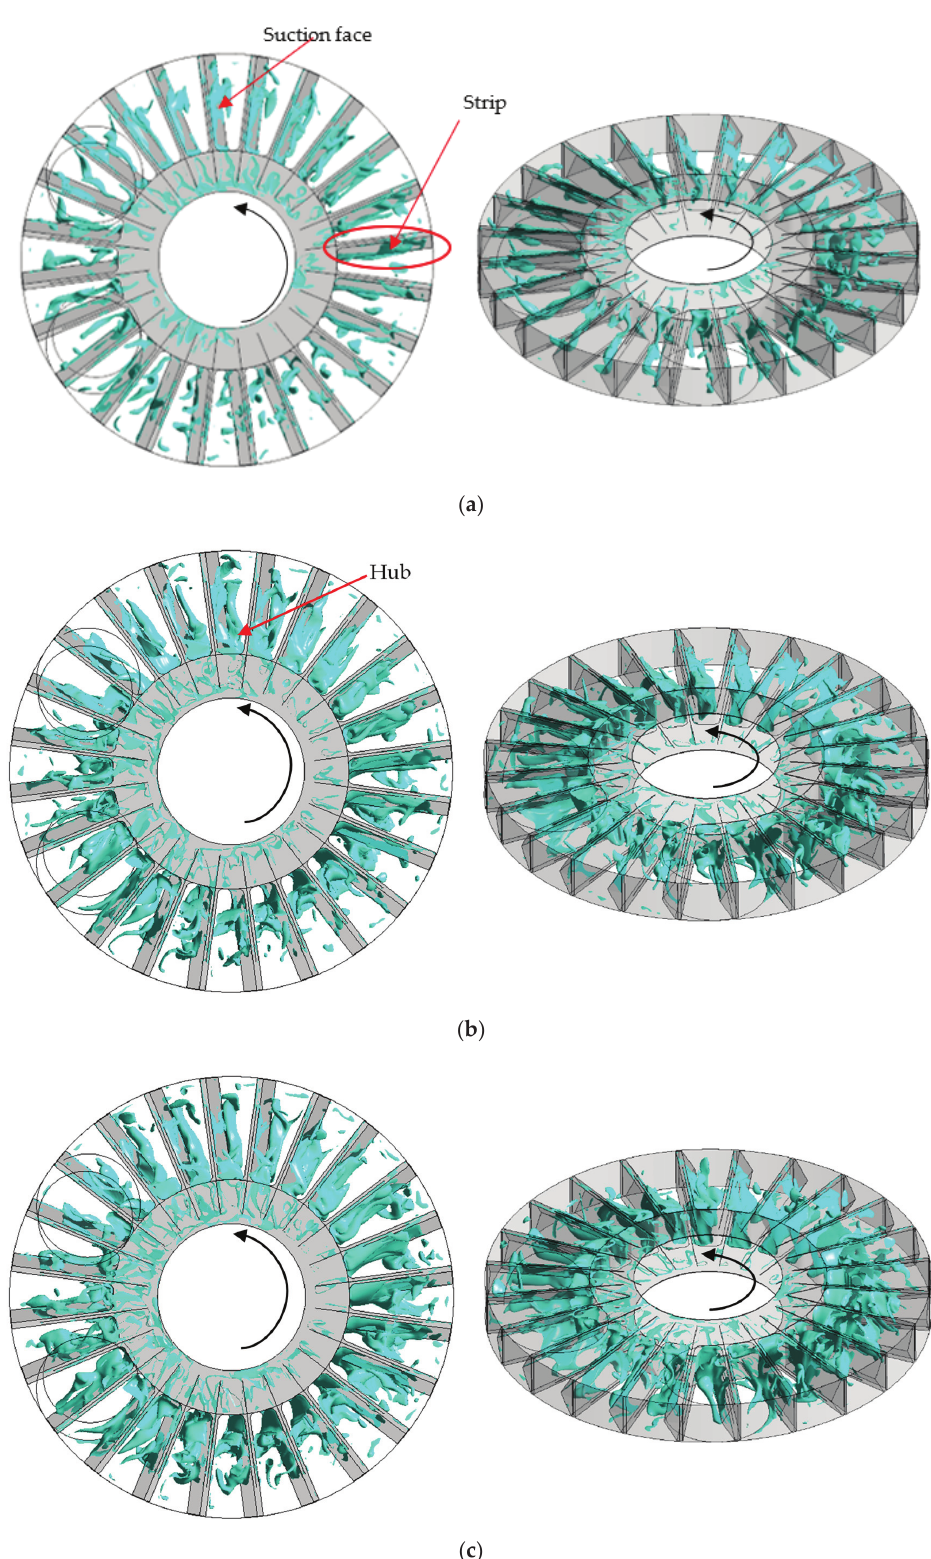
Figure 17. Gas distribution counter in the impeller under di ff erent IGVF and GVF equal to